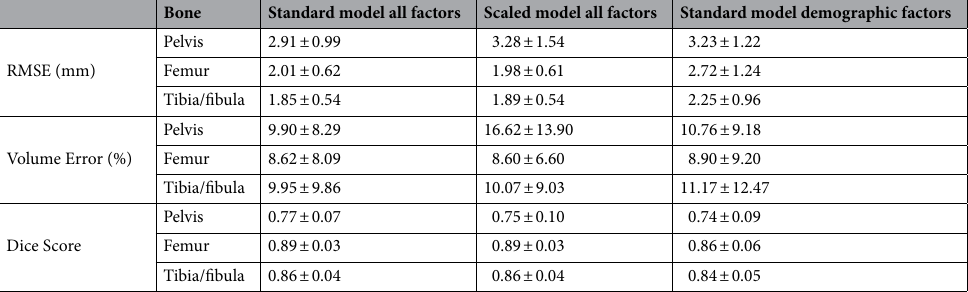
Table 4. Results from the leave one out analysis showing the average RMSE (mm) ± 1SD, percentage volume error ± 1SD, and dice score ± 1SD. The errors represent the difference between shape model generated bone geometries and the segmented geometries (gold standard). “All factors” uses the best demographic and length measurements for prediction. Where demographic factors are age, height, mass, and sex. Shown are the results for the standard shape model and the scaled shape